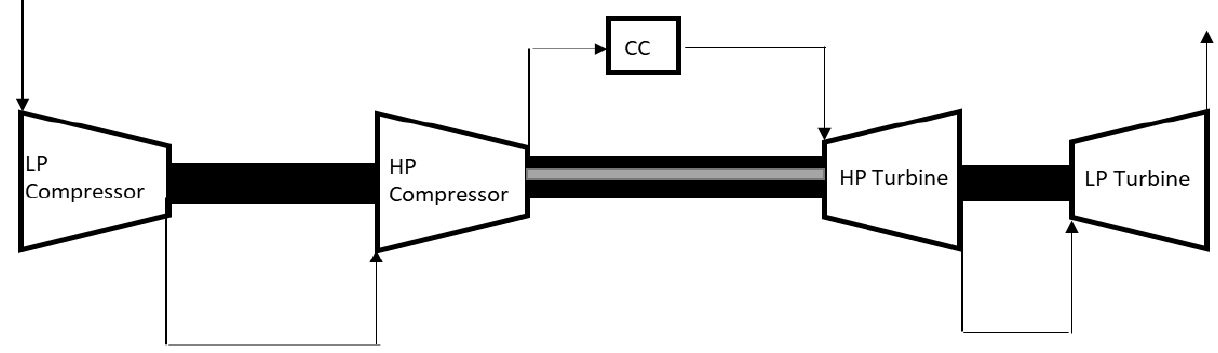
Figure 4. Multi-spool arrangement GT cycle.